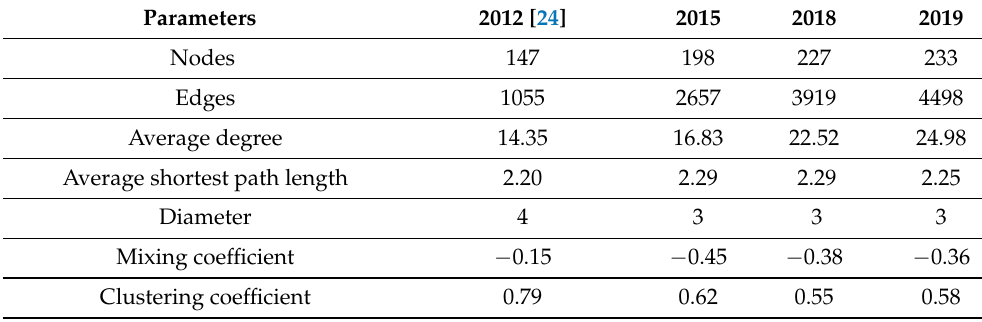
Table 2. A comparison between network parameters in airline networks in different